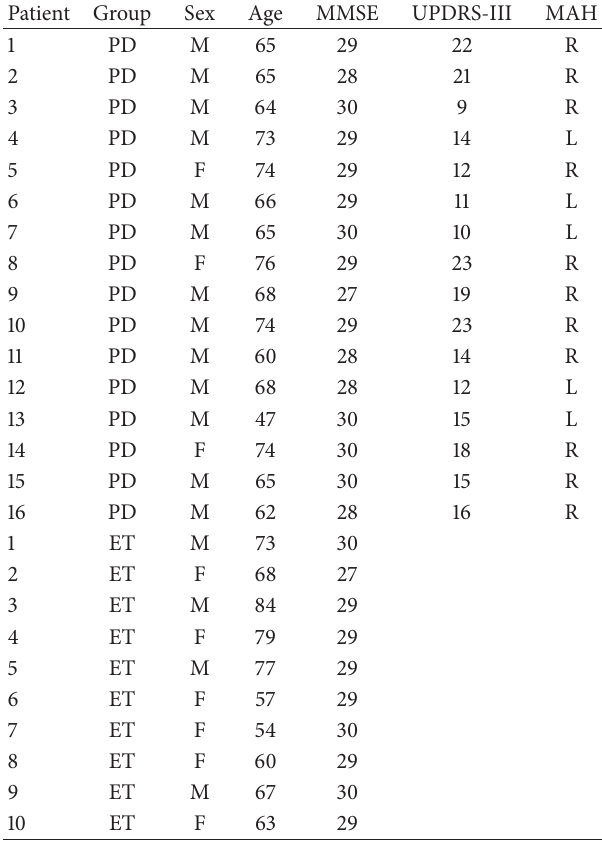
Table 1: Patients demographic